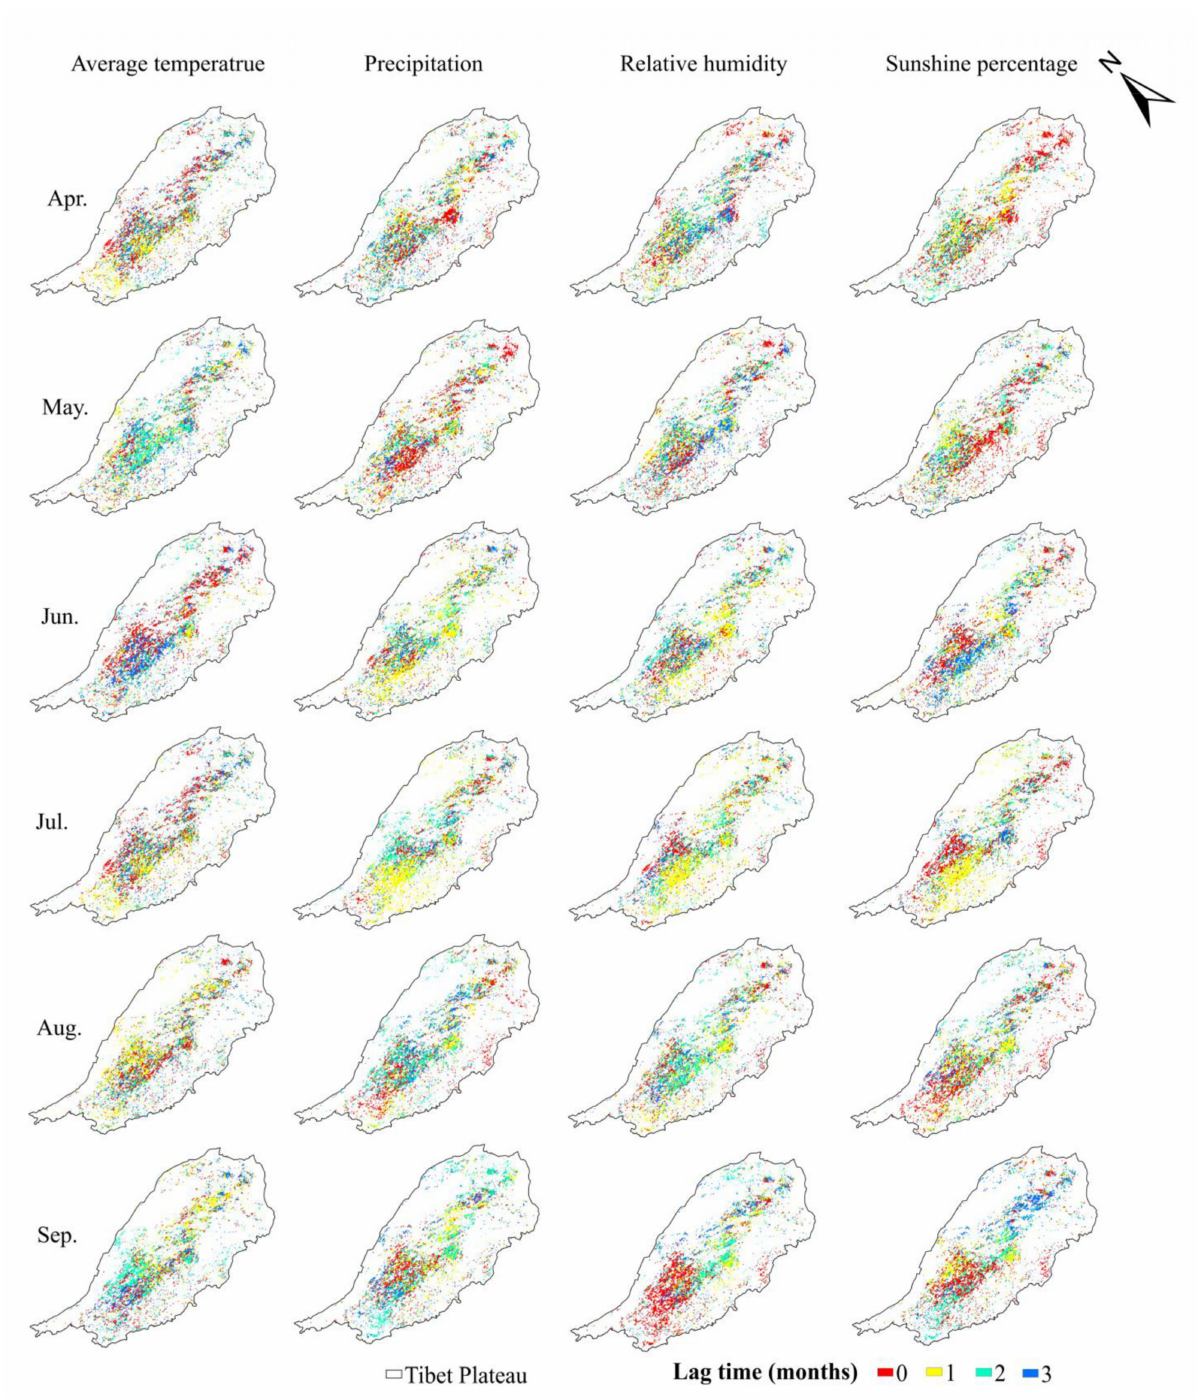
Figure 9. Spatial distribution of the response lag time of the NDVI to average temperature, precipitation, relative humidity and sunshine percentage in different growth stages (from April to September) over the Tibetan